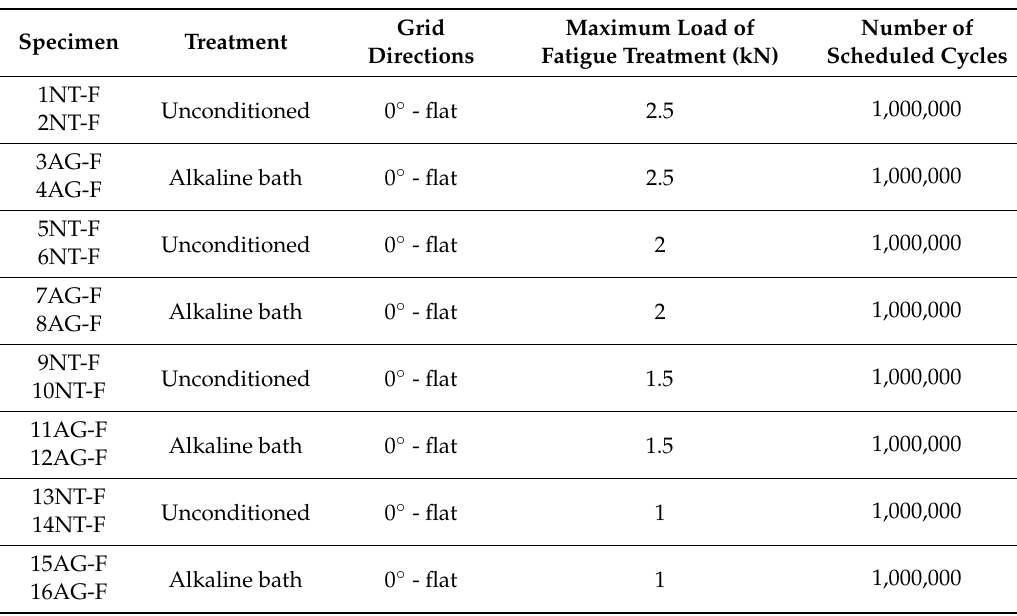
Table 2. Fatigue tests matrix. F was used for those specimens that were subjected to fatigue